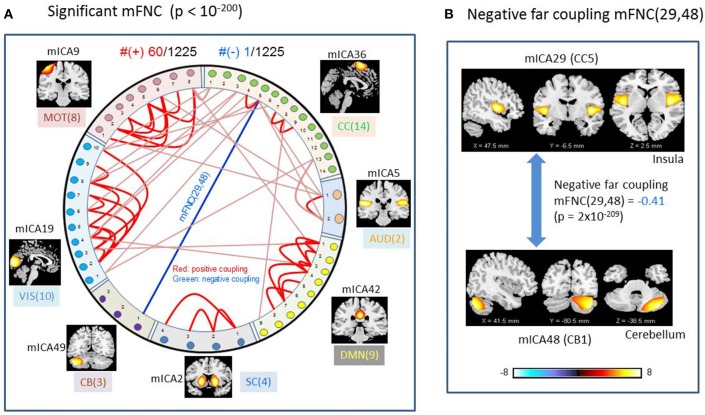
Illustrations of the most significant couplings in mFNC< (p < 10−200). (A) There are 36 intra-domain positive couplings (near, in bright red color) and 18 inter-domain positive couplings (far, in soft red color), and 1 inter-domain negative coupling (far, in blue color). (B) Features of the negative interdomain coupling mFNC(29, 48).